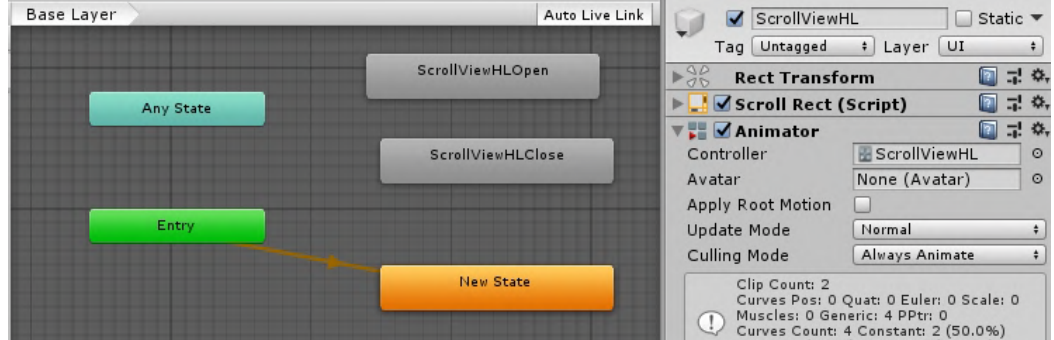
Figure 7: Implementation of displaying the ScrollView component.